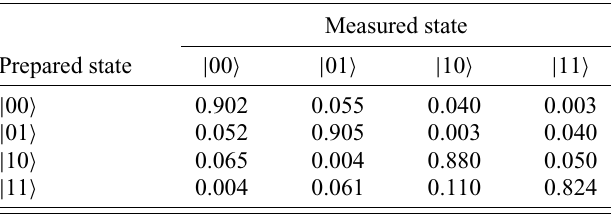
TABLE II. The readout correlation matrix for the two-qubit system, which is prepared 2 × 10 4 times in each state in the com- putational basis {| 00 (cid:4) , | 01 (cid:4) , | 10 (cid:4) , | 11 (cid:4)} . The single-shot mea- surement probabilities are then obtained for each of the four computational states using previously determined discrimination lines in the in-phase–quadrature-phase plane of the measurement signal of each qubit.